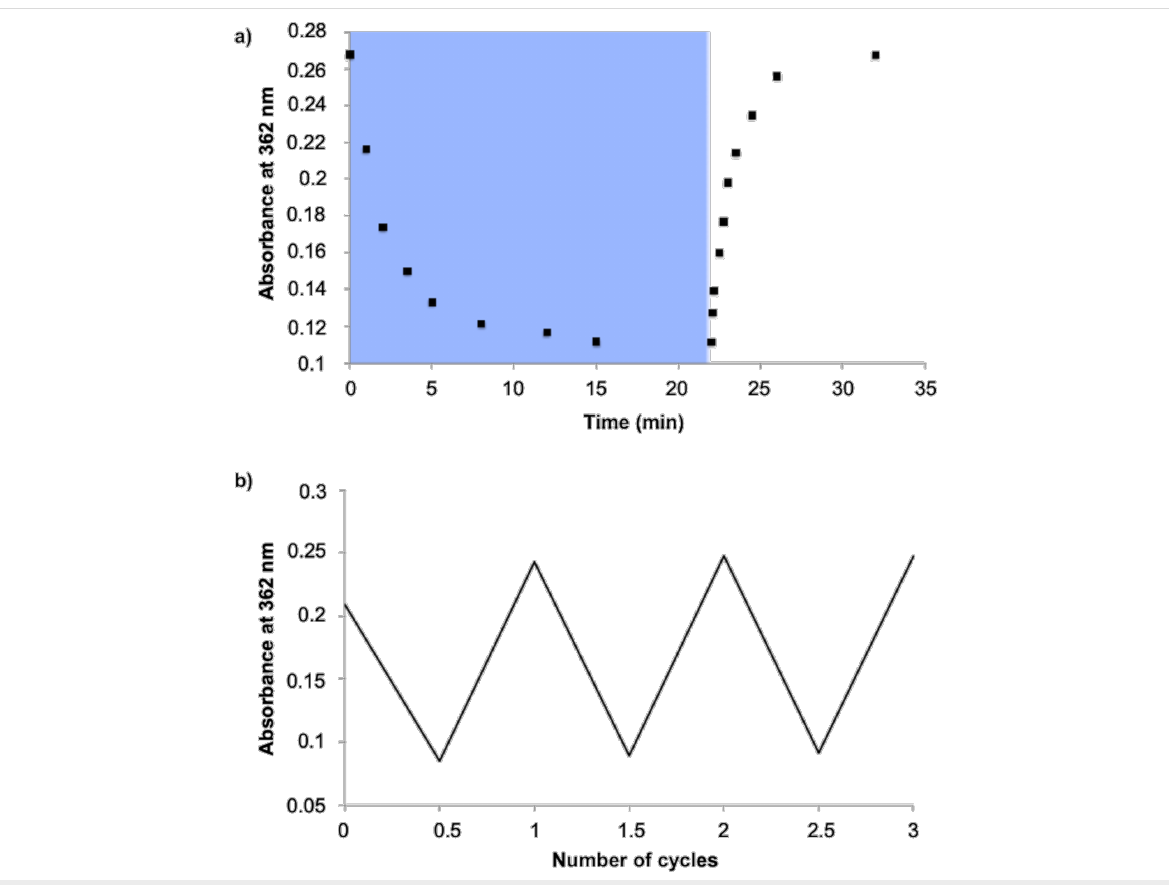
Figure 5: a) Multiple trans–cis cycles of 1 E (40 μ M) indicated by absorption changes at 362 nm in aqueous 0.03 M MOPS buffer at pH 7.2 in pres- ence of KCl (0.1 M) and EGTA (0.011 M). Each cycle corresponds to irradiation at 365 nm (blue), followed by thermal return at room temperature (white). b) Fatigue study of 1 E (40 μ M) after 3